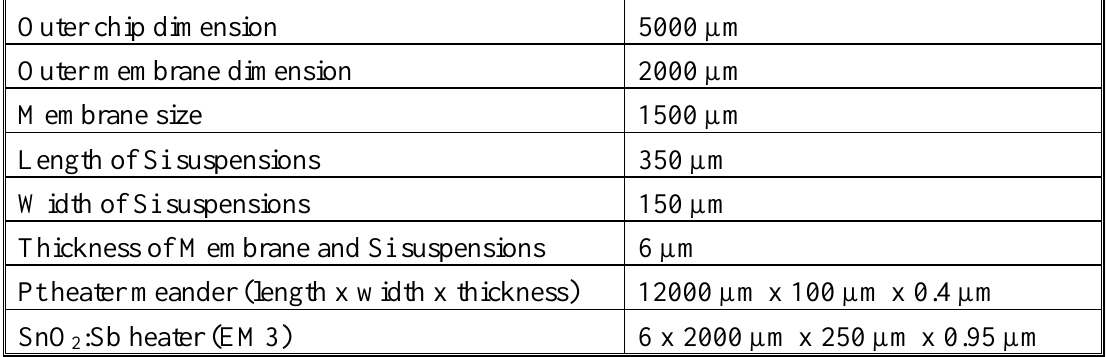
Table 2 : Geometrical hotplate design